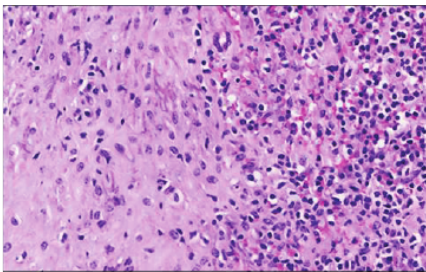
Figure 3: The auricular cartilage plate is disrupted by aggregates of lymphocytes and other mononuclear inflammatory cells. Hema- toxylin and eosin: 40x.